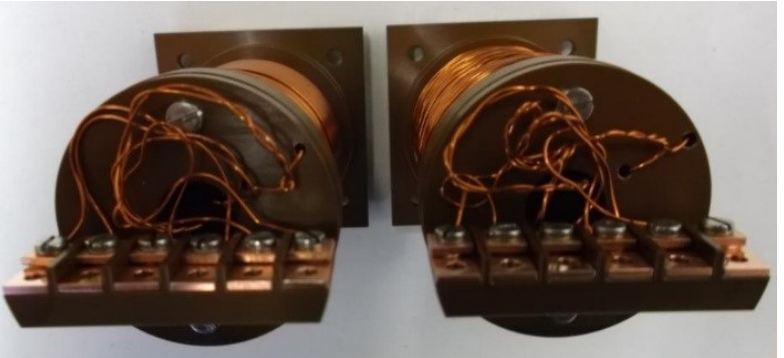
Figure 7. Picture of the coil windings around the peek reel, showing the system for the connection to the external